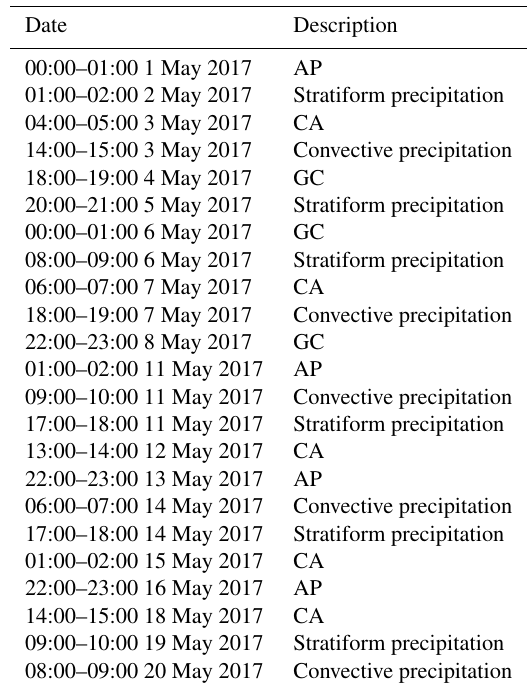
Table 3. List of events used for training membership functions